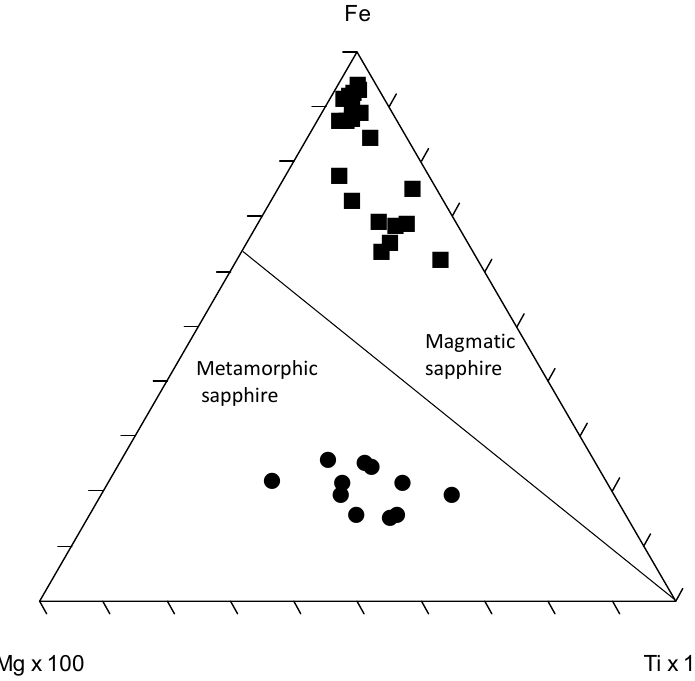
Figure 7. A Fe-Mg × 100-Ti × 10 ternary plot of Ilmen sapphires within ultramafic rocks (bold black circles) are modified after [14]. Values of Ilmen sapphires within syenite pegmatites (bold black squares) are from [6]).